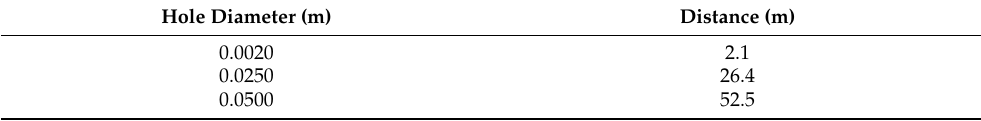
Table 5. Distance at the heat radiation is 37.5 kW/m 2 for each failure scenario.